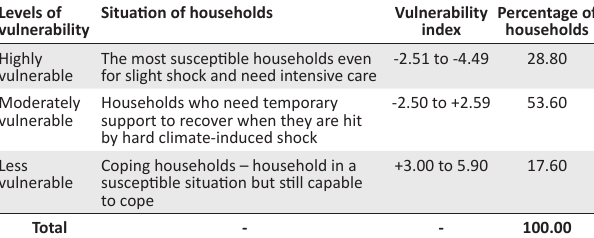
TABLE 5: Vulnerability levels and situations of pastoral households.